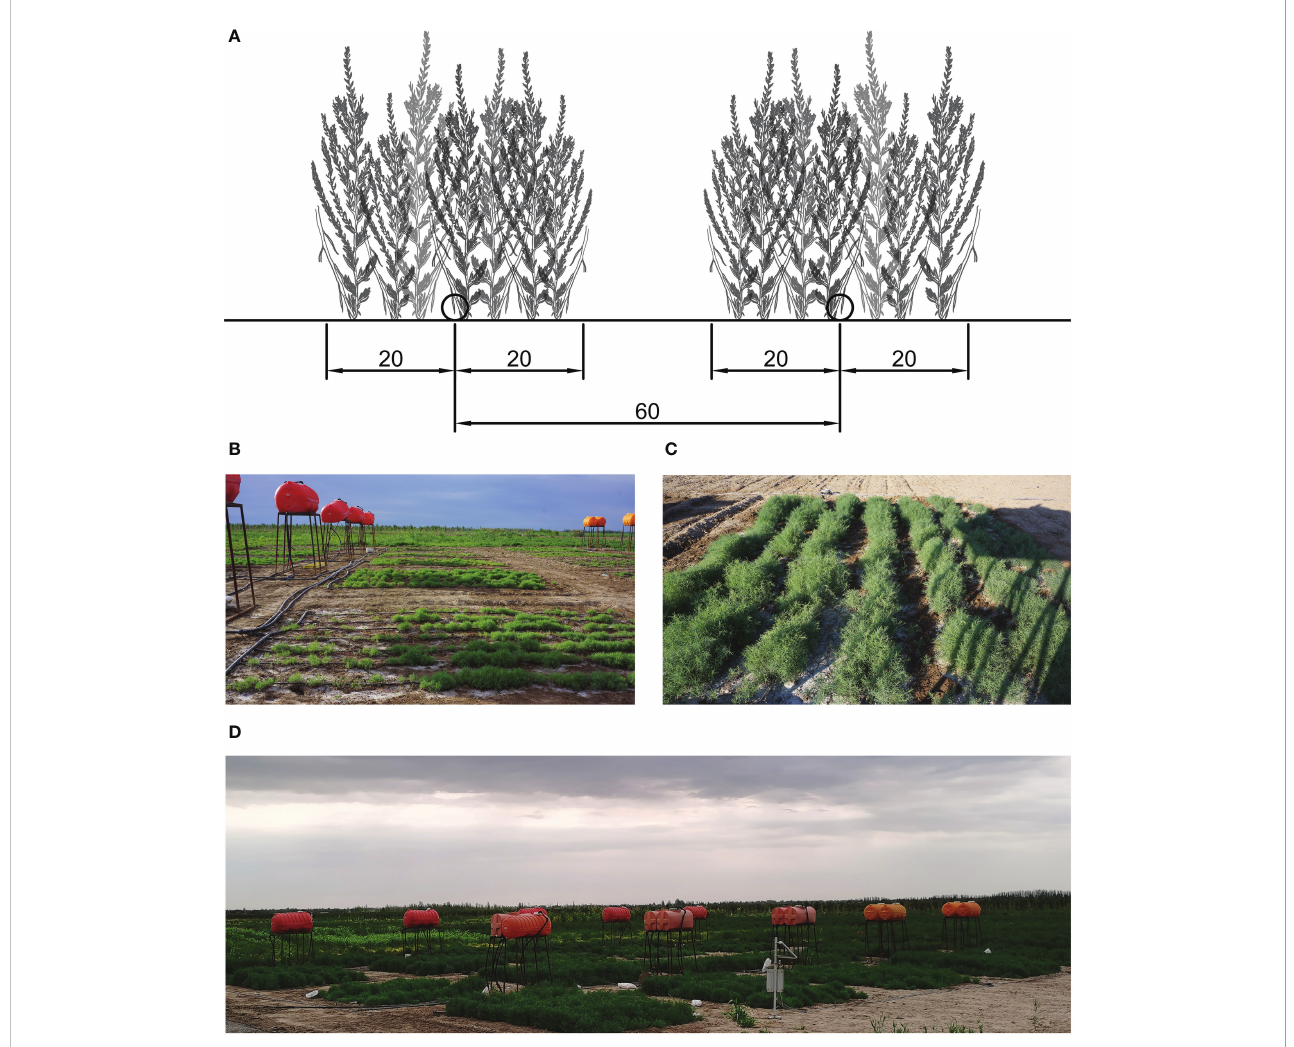
FIGURE 1 (A) Planting design used in the study. The distance between adjacent capillary belts was 60 cm and the planting belt was 40 cm in length. (B) Irrigation system consisting of water tanks, polyvinyl chloride pipes, ball valves, water meters, and capillaries. (C) View of one experimental plot. (D) View of the overall experimental